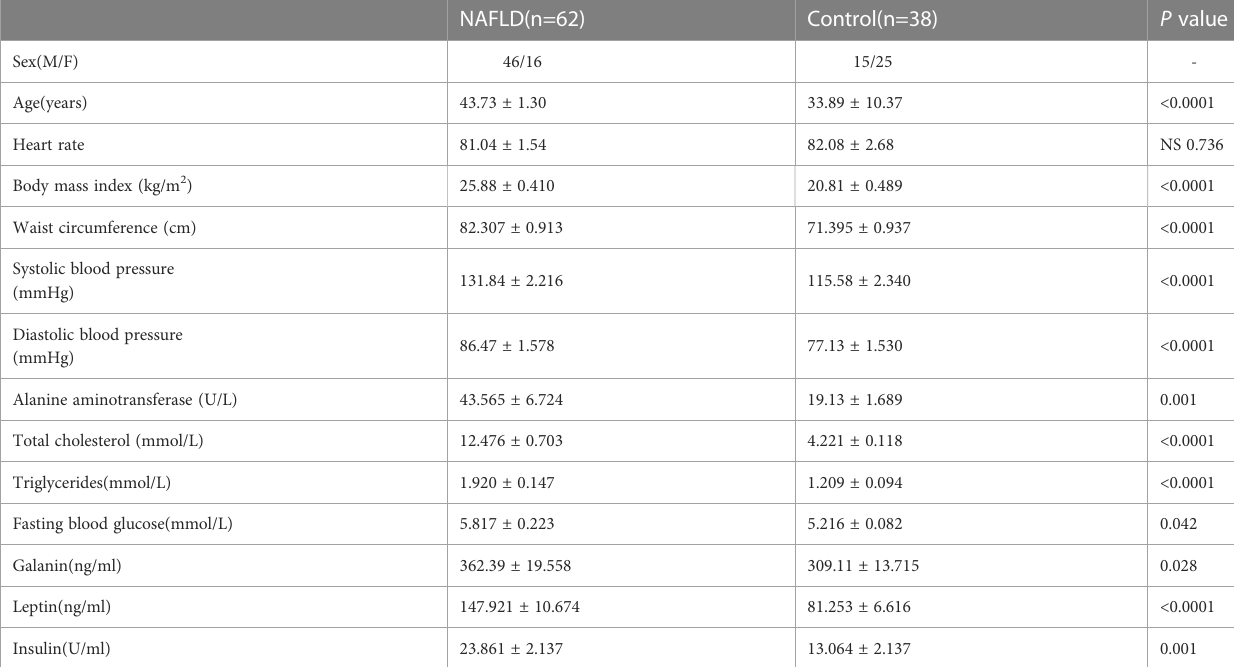
TABLE 1 Galanin levels in patients with